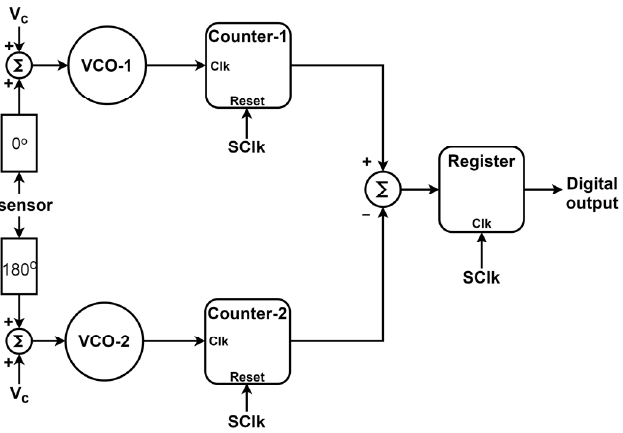
Figure 1. Basic architecture of a differential open-loop VCO-based sensor to digital converter.